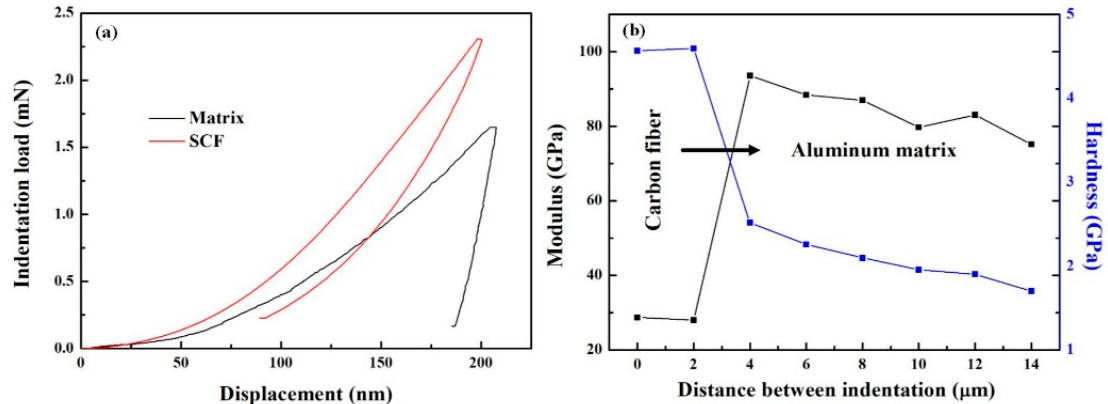
Figure 8. ( a ) Typical load-displacement curves of nanoindentation tests of the SCF and the matrix, ( b ) variation of indentation hardness and modulus of the carbon fiber and adjacent aluminum matrix. Table 1. The tensile tests data of 2024 Al and the composites at di ff erent temperatures.